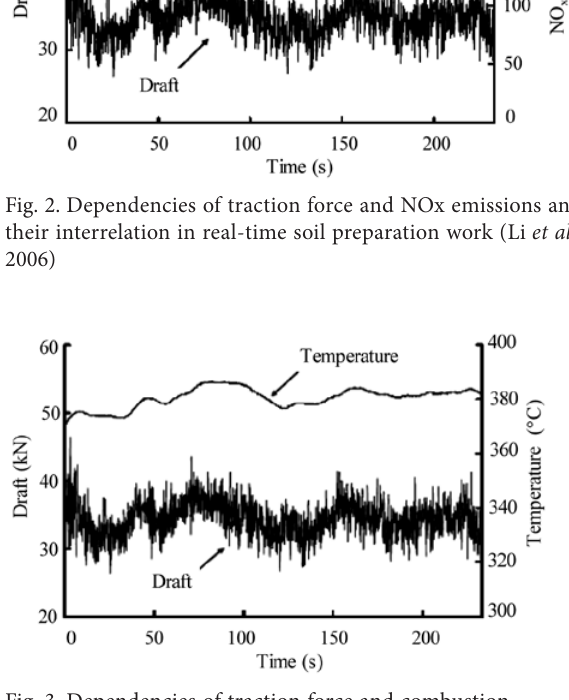
Fig. 3. Dependencies of traction force and combustion gas temperatures and their interrelation in real-time soil preparation work (Li et al .